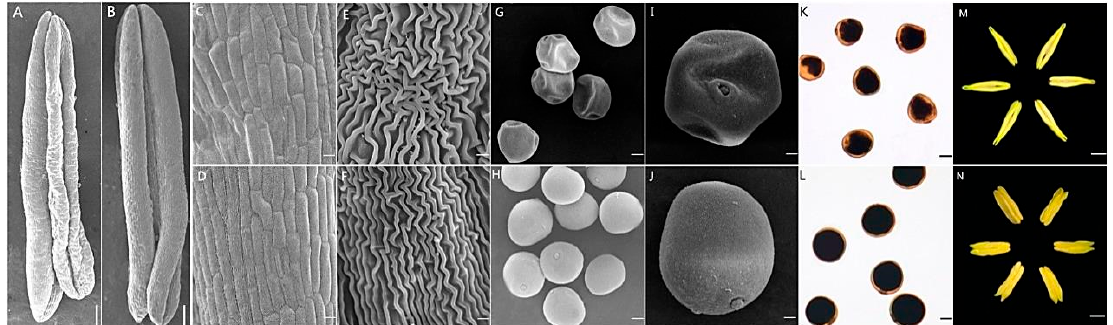
Figure 1. Scanning electron microscopy observations of sterile ( A , C , E , G , I , K , M ) and fertile ( B , D , F , H , J , L , N ) wheat plants during the trinucleate (TNP) stage. ( A , B , M , N ): anthers; ( C , D ): outer epidermal cells; ( G , H , I , J ): TNP cells. Bars: ( A , B ): 0.5 mm; ( C , D , G , H ): 100 μ m; ( E , F ): 10 μ m; ( I , J ): 30 μ m; ( K – N ): 50 μ m.